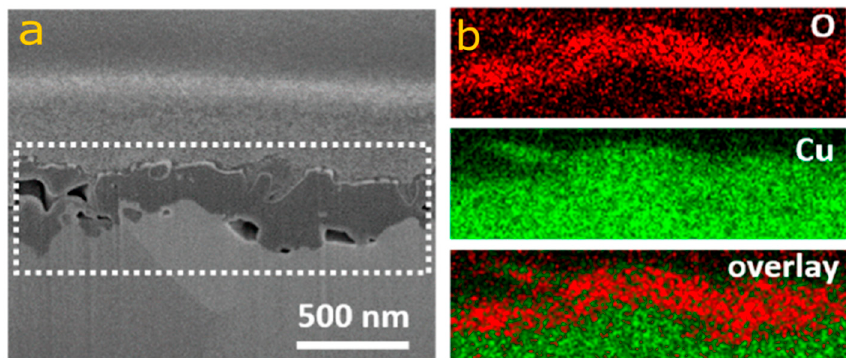
Figure 5. SEM cross-section image of OD-Cu catalyst prepared via square-wave electrochemical redox treatment ( a ) and its EDX mapping ( b ) showing oxide layer on copper surface. Reproduced from [128] © 2020 American Chemical Society.